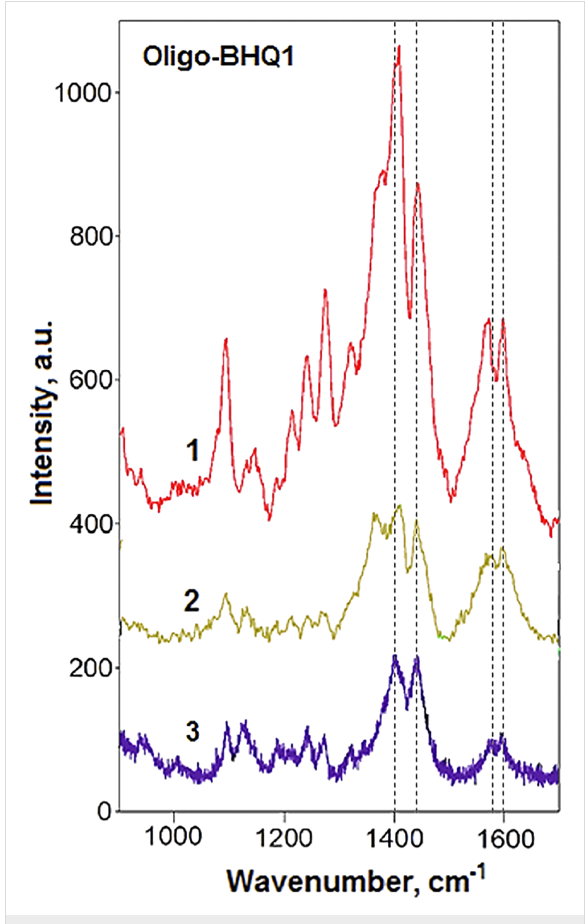
Figure 8: SERS spectra of BHQ1-labeled oligonucleotide drop-cast from 10 − 5 M solution onto substrates modified with (1) Cu 2+ (added into the analyte solution) and (2) Cu 2+ (surface treatment); (3) Raman spectrum of BHQ1 in Ag NP